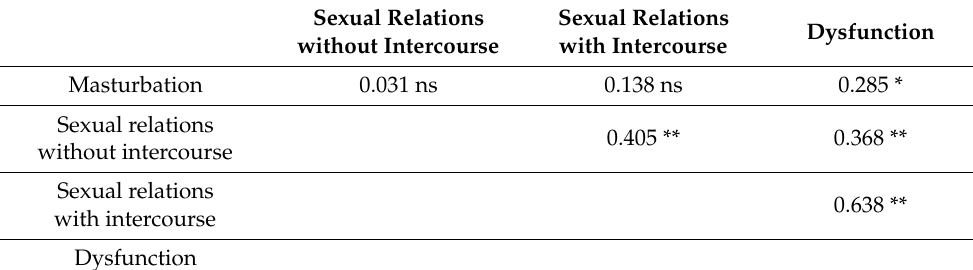
Table 6. Correlations among factors.